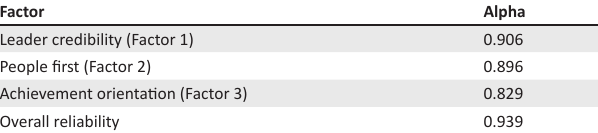
TABLE 9: Questionnaire